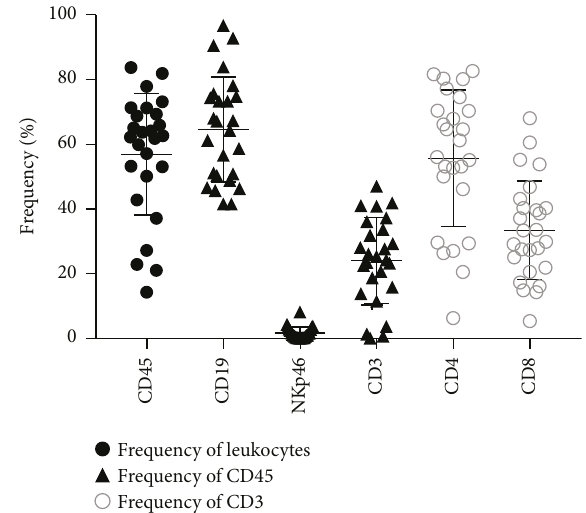
Figure 1: NOD-scid IL2rg − / − (NSG) mice injected with fetal liver- derived CD34 + hematopoietic progenitor cells were reconstituted with human immune cells. Peripheral blood of reconstituted NSG mice was analyzed 3 months after injection of human hematopoietic progenitor cells. The frequencies of di ff erent immune cell compartments are indicated. Frequencies of human CD45 + cells within the leukocyte gate, frequencies of CD19 + B cells, NKp46 + NK cells, and CD3 + T cells within human CD45 + cells, and frequencies of CD4 + and CD8 + T cells within CD3 + cells are shown. Horizontal lines represent the mean and SD. Data are from 3 di ff erent reconstitution cohorts with CD34 + cells derived from 3 di ff erent fetal liver